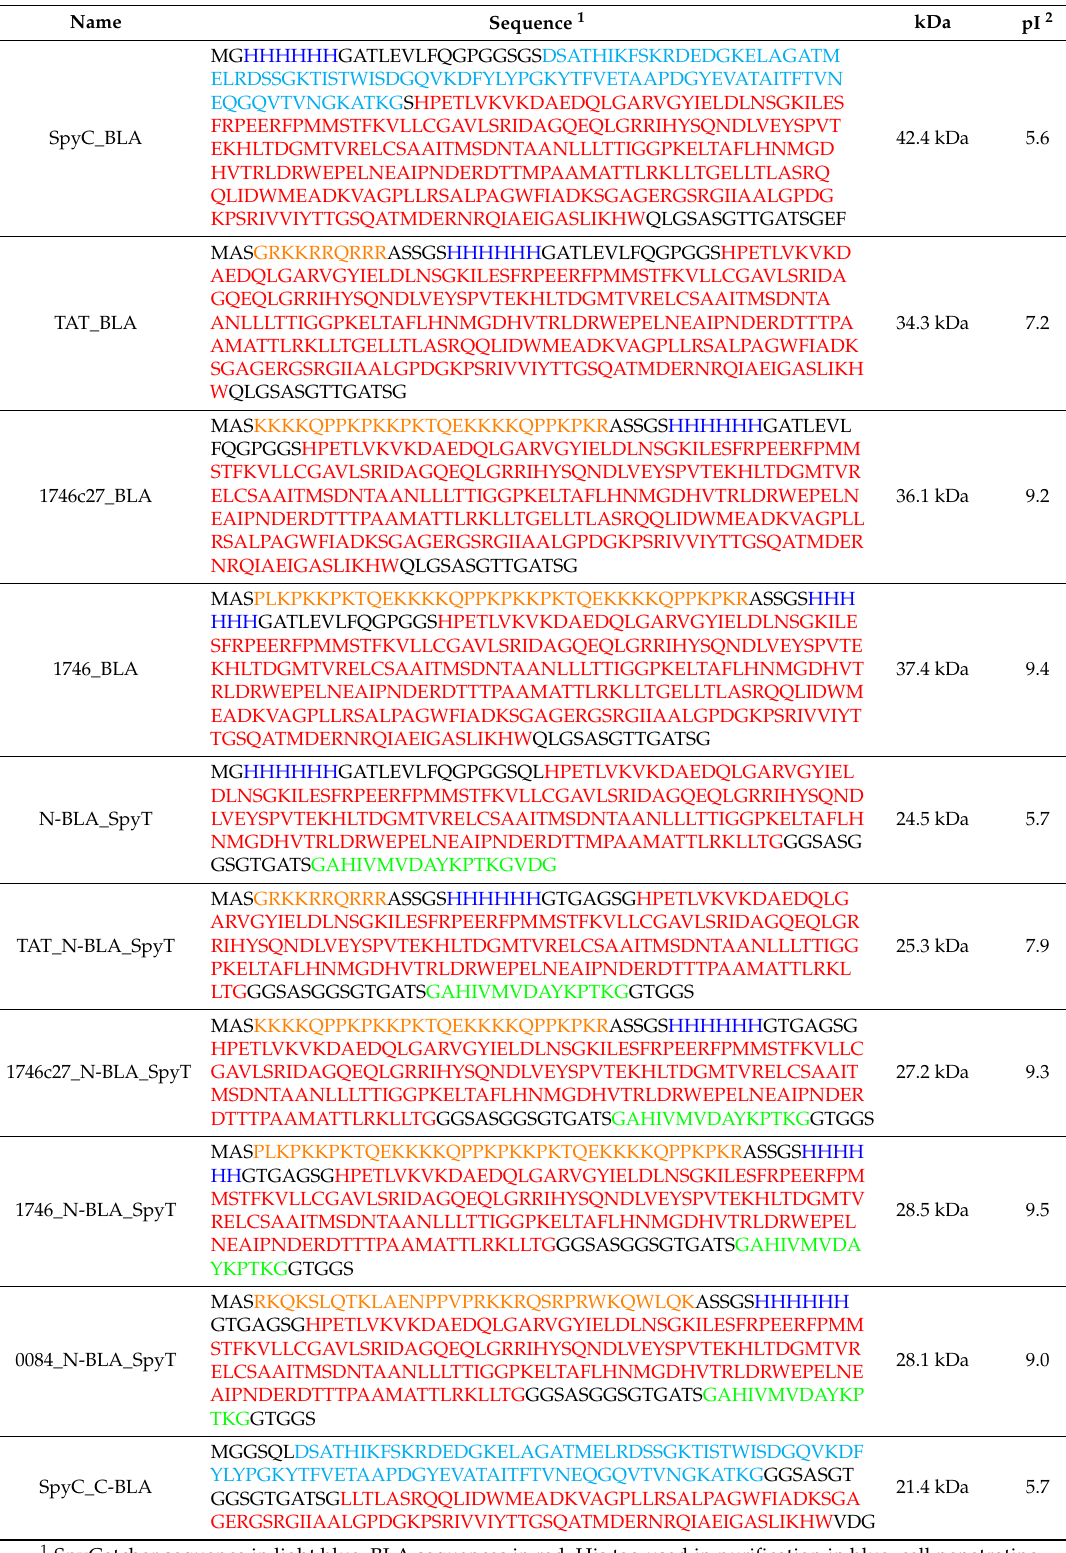
Table A2. SpyCatcher β -lactamase fusion